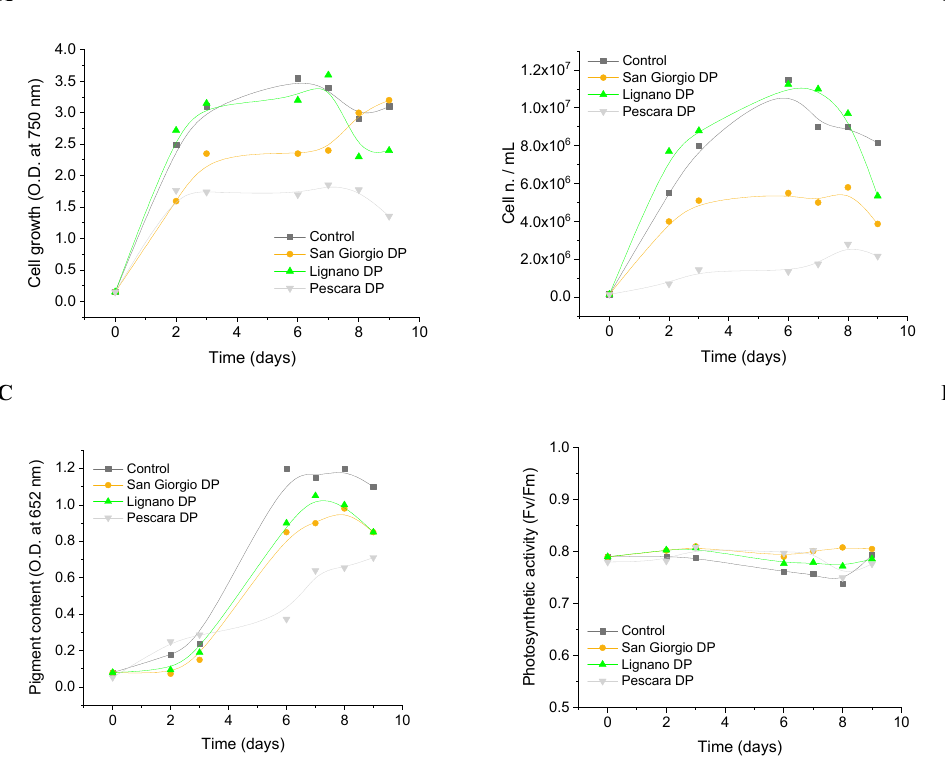
Figure 2. C. reinhardtii physiological characterization. Cell culture growth reported as absorbance at 750 nm ( A ) and cell number/mL ( B ). ( C ) Chlorophyll content. ( D ) Maximum fluorescence yield FV/FM calculated on each Kautsky curve. Incubation time: 9 days under continuous light (50 µL photons m − 2 s − 1 ). Average values ± SE ( n = 3).